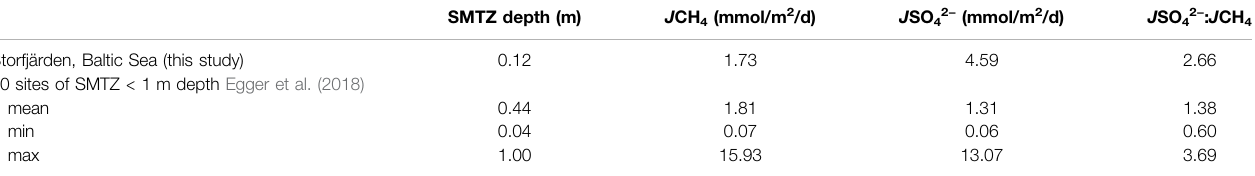
TABLE5| Comparisonof fl uxesofmethane( J CH 4 )andsulfate( J SO 42 − )intotheSMTZatStorfjärdenwith40otherlocationsinthemarinerealmwithSMTZdepth < 1 m(data from Egger et al. (2018). Only sites with data for all parameters were used in the analysis. SMTZ depth